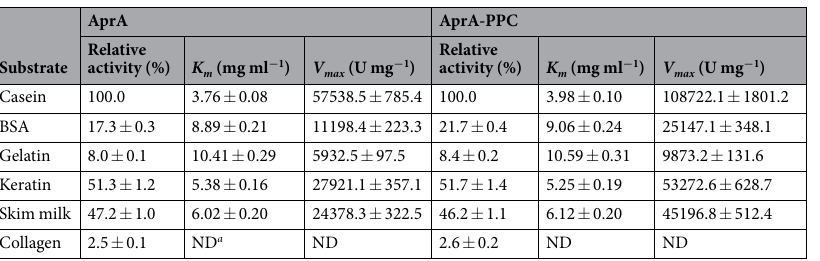
Table 4. Substrate specificity and kinetic parameters of recombinant AprA and AprA-PPC. a ND means not